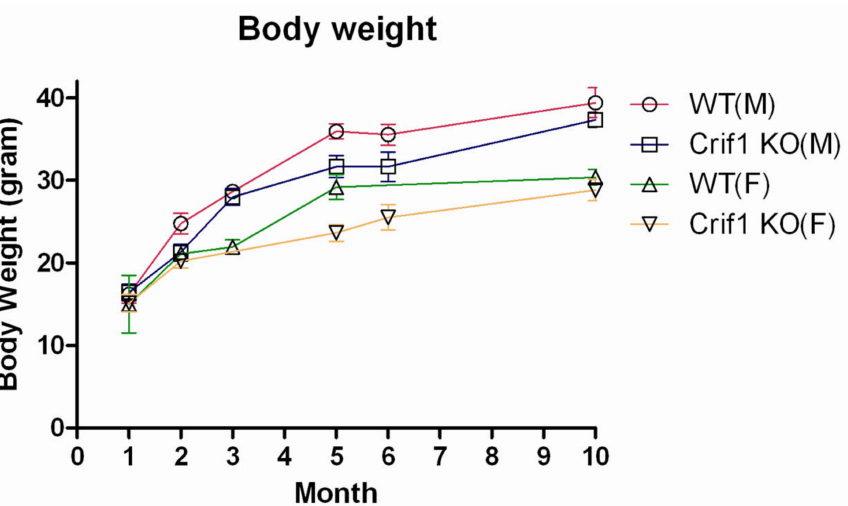
Figure 4. Body weight of wild-type (WT) and CR6-interacting factor-1 knockout (CRIF1-KO)